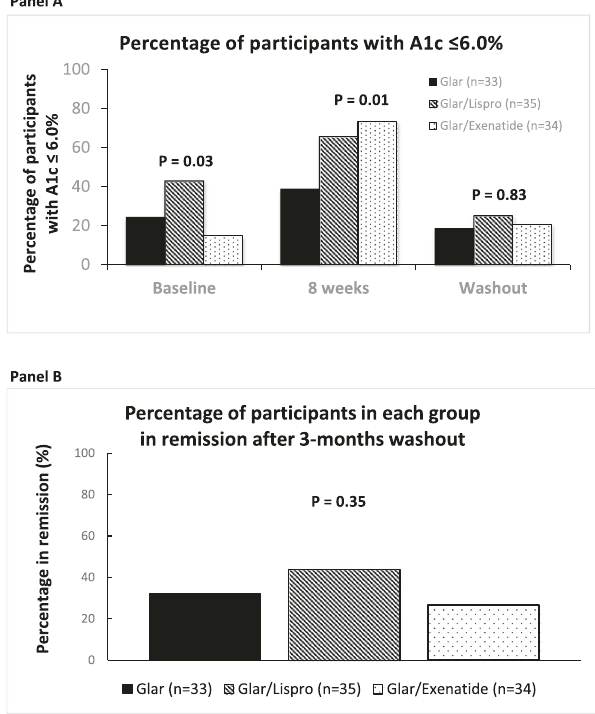
Fig. 5 | Percentages of participants with A1c ≤ 6.0% and remission of diabetes. A PercentageofparticipantsineachgroupwithA1c ≤ 6.0%atbaseline,8-weeksand washout,respectively. B Percentageofparticipantsineachgroupwithremissionof diabetesafter3-monthswashout.Chi-squaretestwasusedtocompareproportions betweengroups.Two-tailed P -values<0.05wereconsideredstatisticallysigni fi cant (multiple comparisons not considered). Number of participants: Glar n =33; Glar/ Lispro n =35; Glar/Exen n